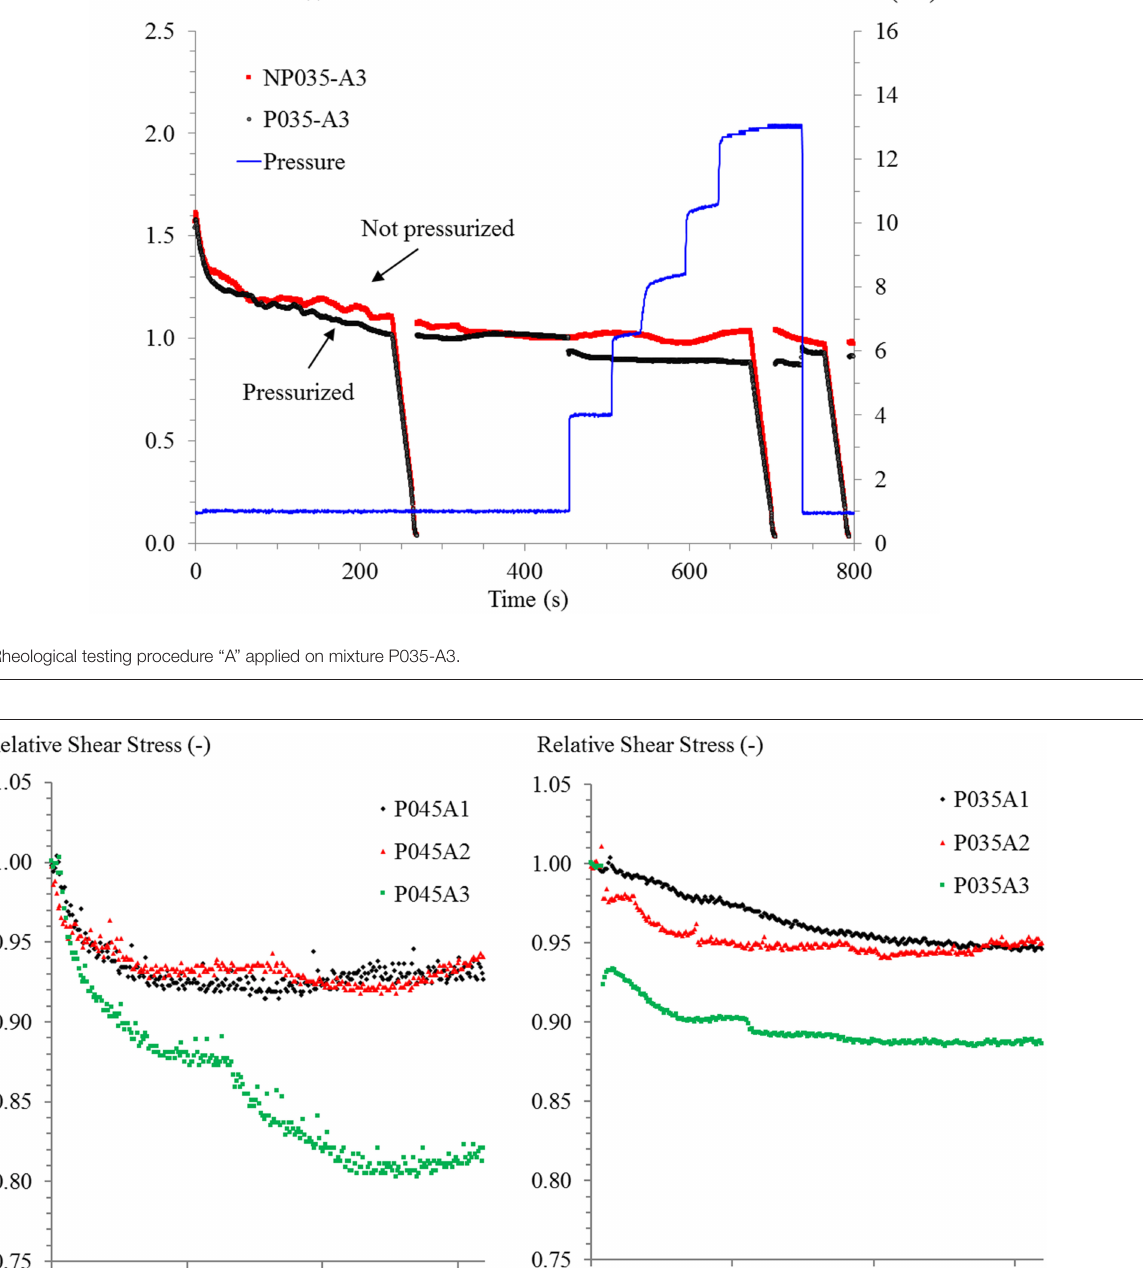
of the differential viscosity of the flow curves. When w/c =